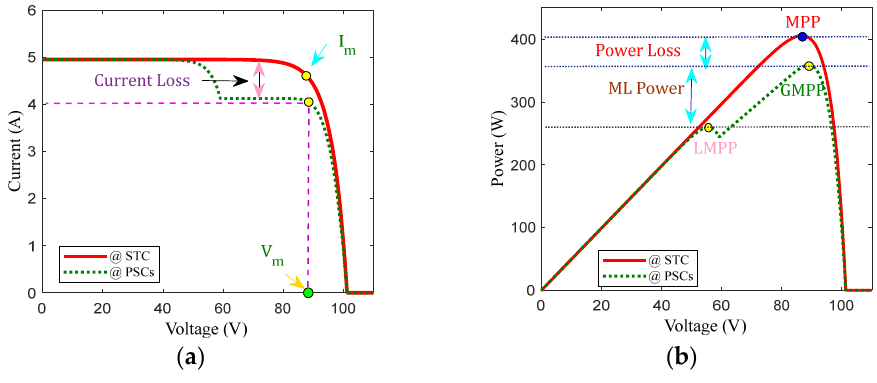
Figure 6. Characteristics of ( a ) I–V and ( b ) P–V under PSCs.